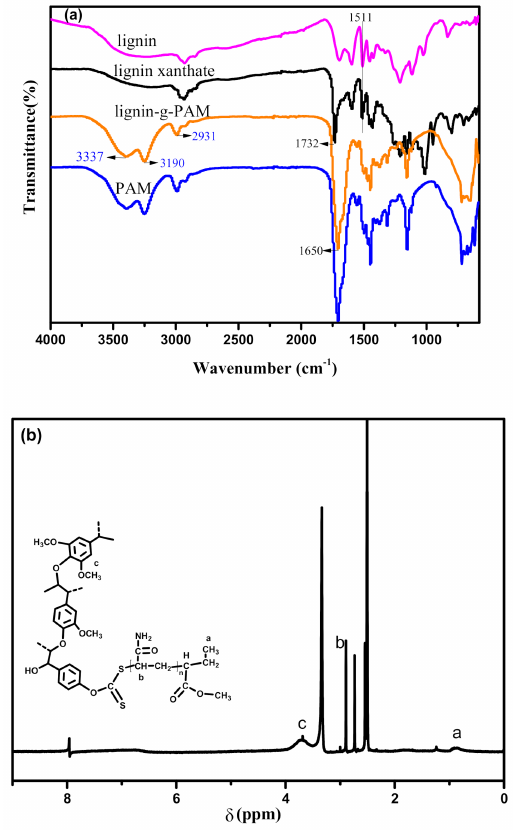
Figure 2. Attenuated total reflectance–Fourier transform (ATR-FTIR) spectra of lignin, lignin xanthate, lignin-g-PAM, and PAM ( a ), and 1 H NMR spectrum of lignin-g-PAM ( b ). Two peaks appeared at 0.9 ppm and 3.7 ppm, as shown in the 1 H NMR spectrum of lignin-g-PAM (Figure 2b), which are associated with the protons of the end –CH 3 from the xanthates group and that of the methoxy group from lignin,